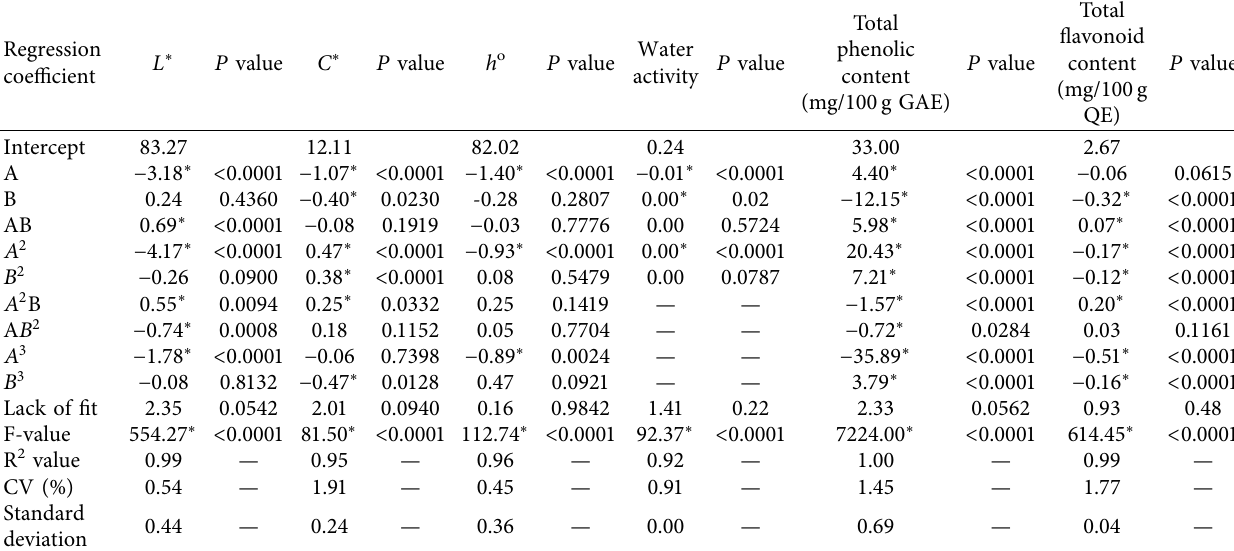
Table 3: Model statistics and regression coefcient for each response of tray-drying